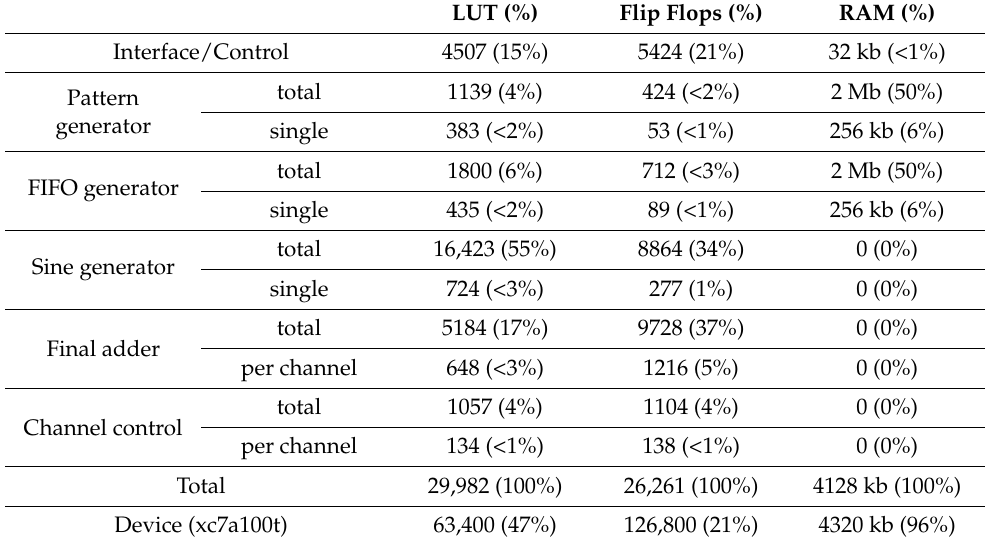
Table 2. Hardware resources of the architecture elements. RAM resources are expressed in kbits instead of blocks to facilitate comparison. We consider that device block RAMs are 32 kb instead of 36 kb, to reflect the actual percentage of blocks used. All percentages are architecture related, except for the final table line, where percentages are